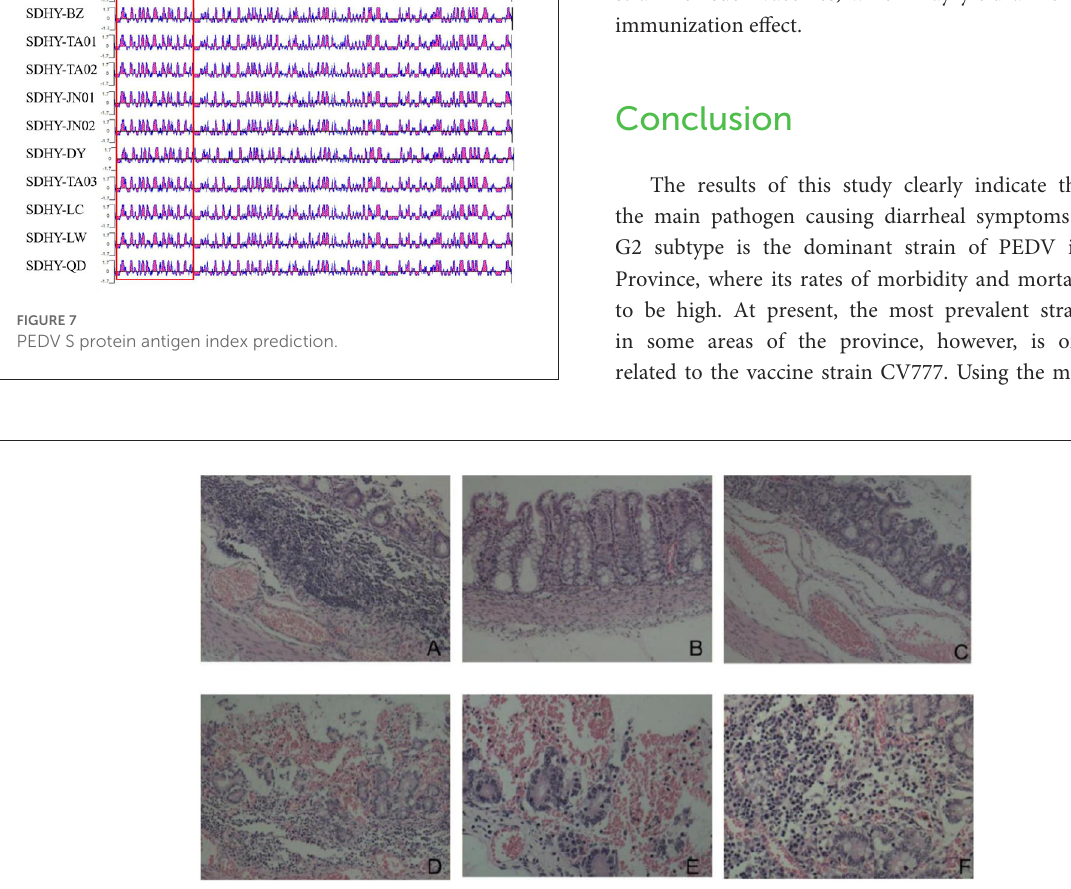
FIGURE8 Histopathological changes (HE dyeing). (A) Duodenal villi had atrophied and detached, submucosa was congested, × 100; (B) increased goblet cells and necrosis of epithelial cells, × 200; (C) Necrosis of jejunal mucosal epithelial cells and submucosal hyperemia, × 100; (D) rupture and shedding of jejunal villi, × 100; (E) jejunum full of necrotic and exfoliated epithelial cells, × 100; (F) congestion and inflammatory cell infiltration in the lamina propria of gastric mucosa, ×